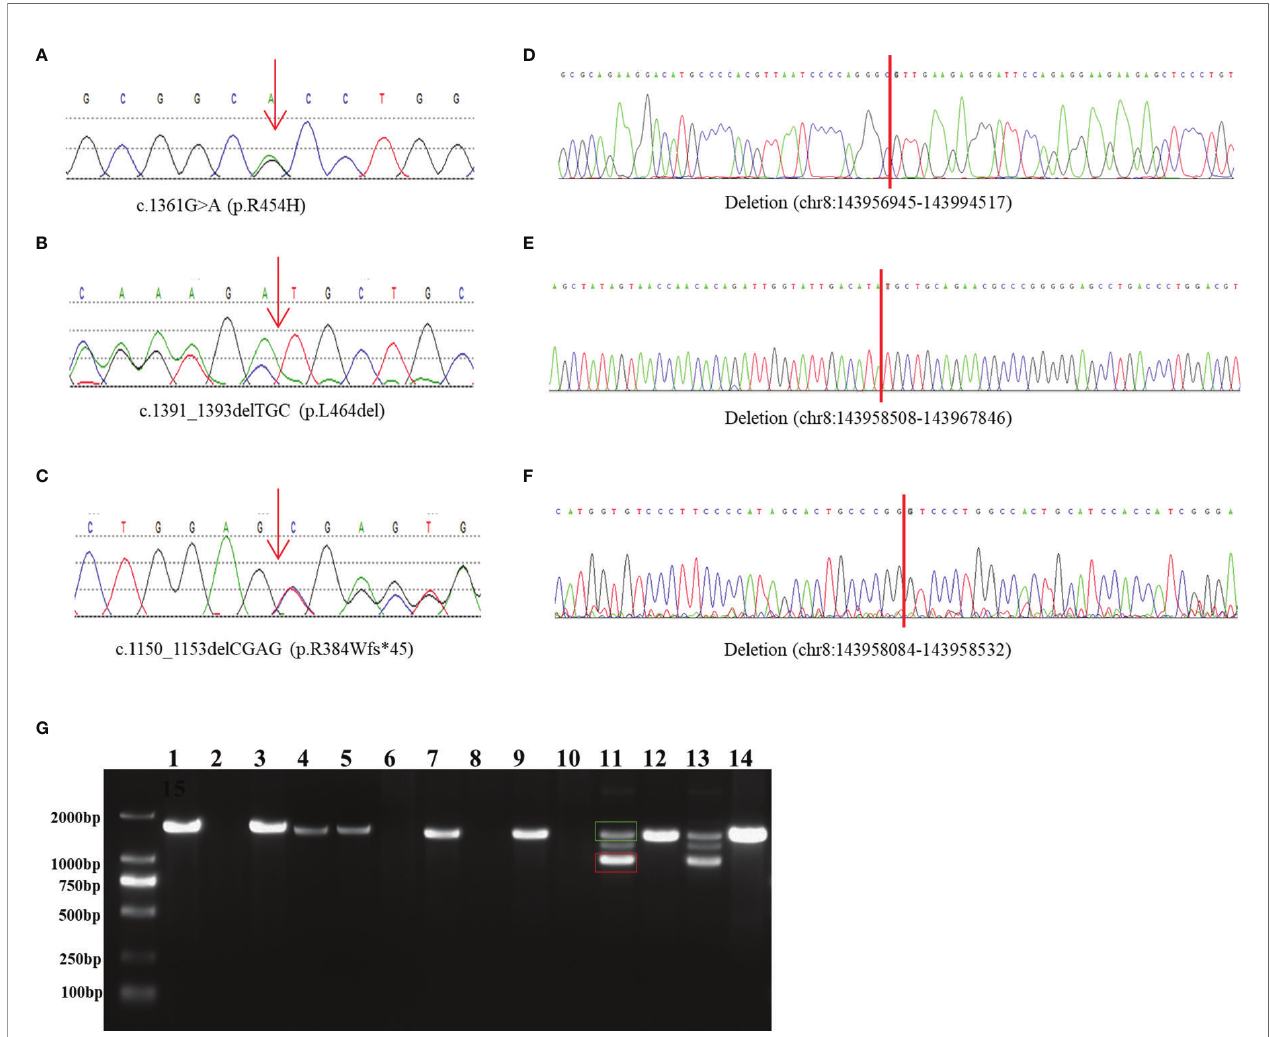
FIGURE 1 | Identi fi cation and characterization of rearrangements in three patients. (A – C) Sanger traces for CYP11B1 -speci fi c PCR products show the point mutation and indels in patient 1 (A) , patient 2 (B) , and patient 3 (C) . (D – F) Sanger traces for breakpoint-speci fi c PCR products for CYP11B1 rearrangements. They show the sequences around breakpoints in patient 1 (D) , patient 2 (E) and patient 3 (F) . Red lines indicate the location of genomic rearrangement. (G) Electrophoretogramof PCR products for the CYP11B1 rearrangements detected in three patients. Lanes 1 – 6: CYP11B2/CYP11B1 allele in patient 1, his father, his mother, carrier 1, carrier 2, and control, respectively. Lanes 7 – 10: CYP11B1 deletion fragment in patient 2, her father, her mother, and control, respectively. Lanes 11 – 14: The wild-type allele (green box) and the deletion allele (red box) of CYP11B1 in patient 3, his father, his mother, and the control,